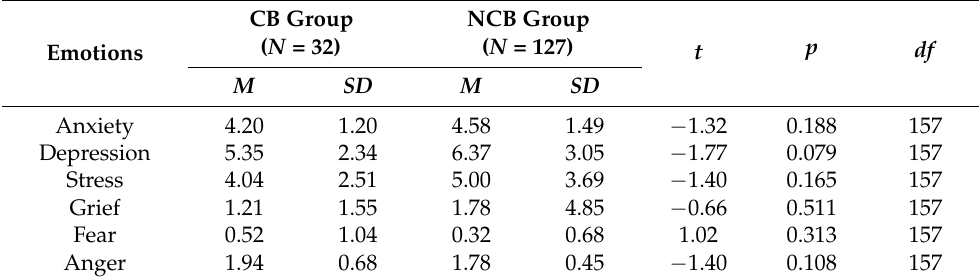
Table 3. Comparison of emotions between the CB group and NCB group.